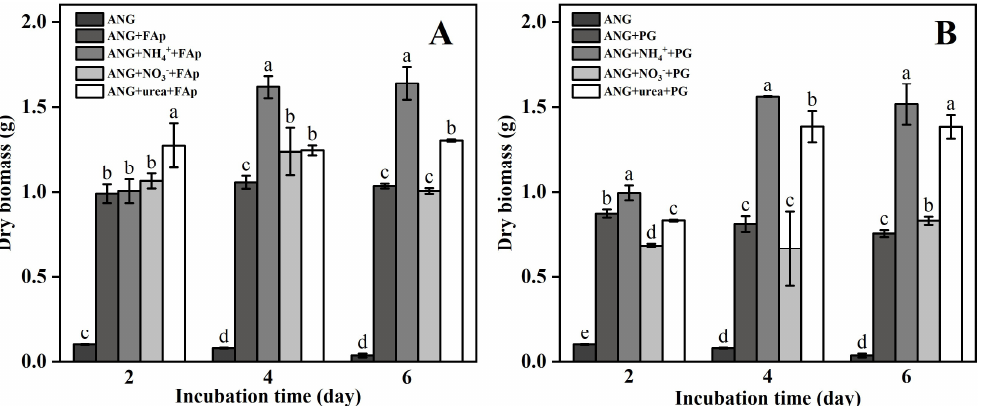
Figure 1. The dry biomass in the FAp ( A ) and PG ( B ) treatments during the incubation (2, 4, and 6 days). The error bars represent the standard deviations of three replicates. The different lower-case letters indicate a significant difference between the treatments ( p < 0.05). The significant differences among the treatments were identified by Tukey test ( p < 0.05) via one-way ANOVA.